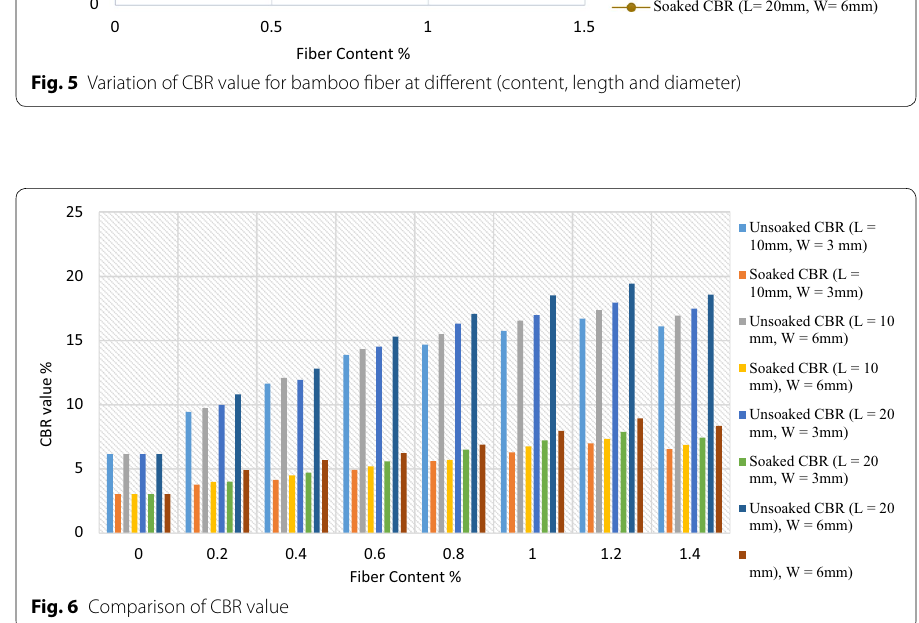
Fig. 6 Comparison of CBR